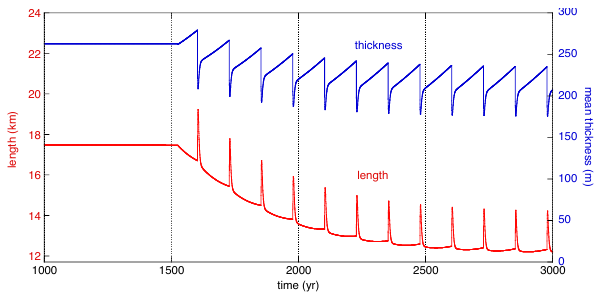
Figure 6. Surge event as imposed to the model by Eq. Fig. 6. Surge event as imposed to the model by eq. (16). 3